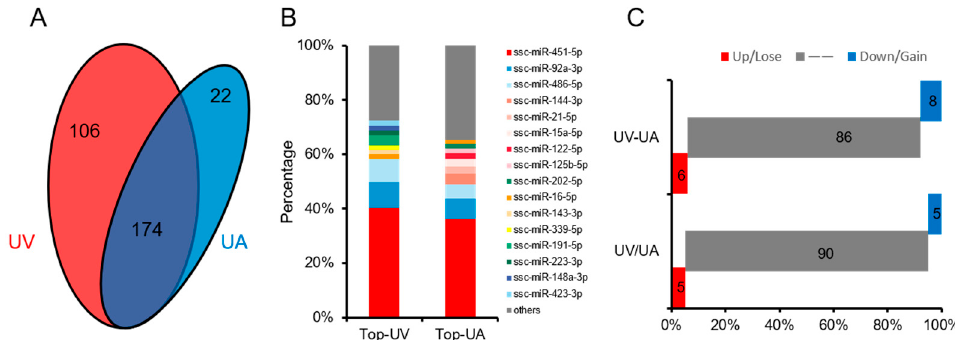
Figure 2. Characteristics of pig umbilical cord and its effect on birth weight. ( A ) The Venn diagrams represent all the numbers of expressed miRNAs. ( B ) Composition of highly expressed miRNAs. ( C ) Differential expression of the top 100 miRNAs in UVB and UAB (up/down: |log2Fold change| ≥ 1.5, lose/gain: |UV − UA| ≥ 0.2).